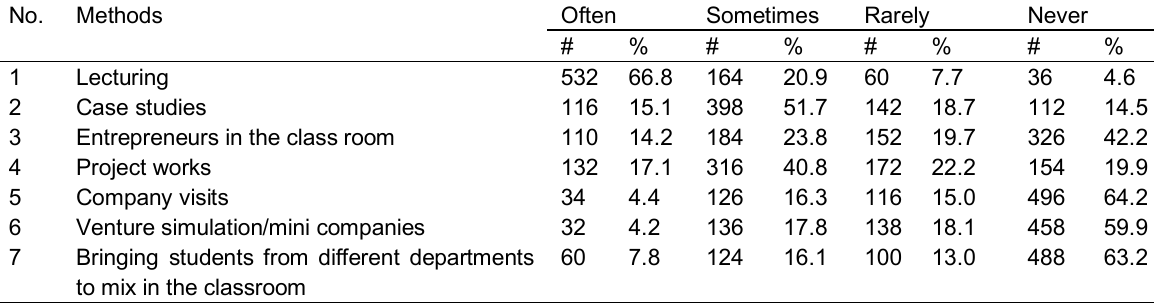
Table 5: Main teaching methods in the entrepreneurship education